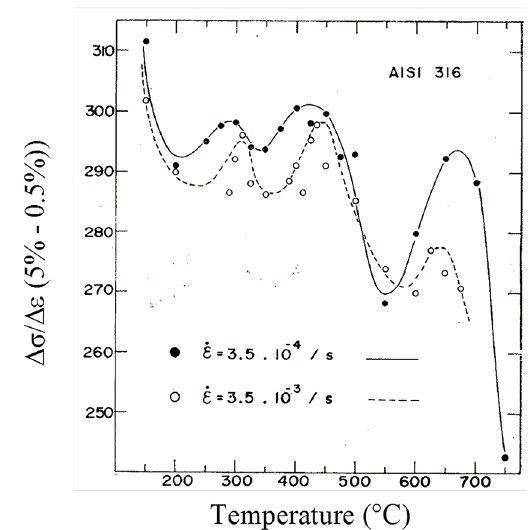
Figure 4. Variation of the average work hardening rate of type AISI 315 stainless steel with temperature for two strain rates.